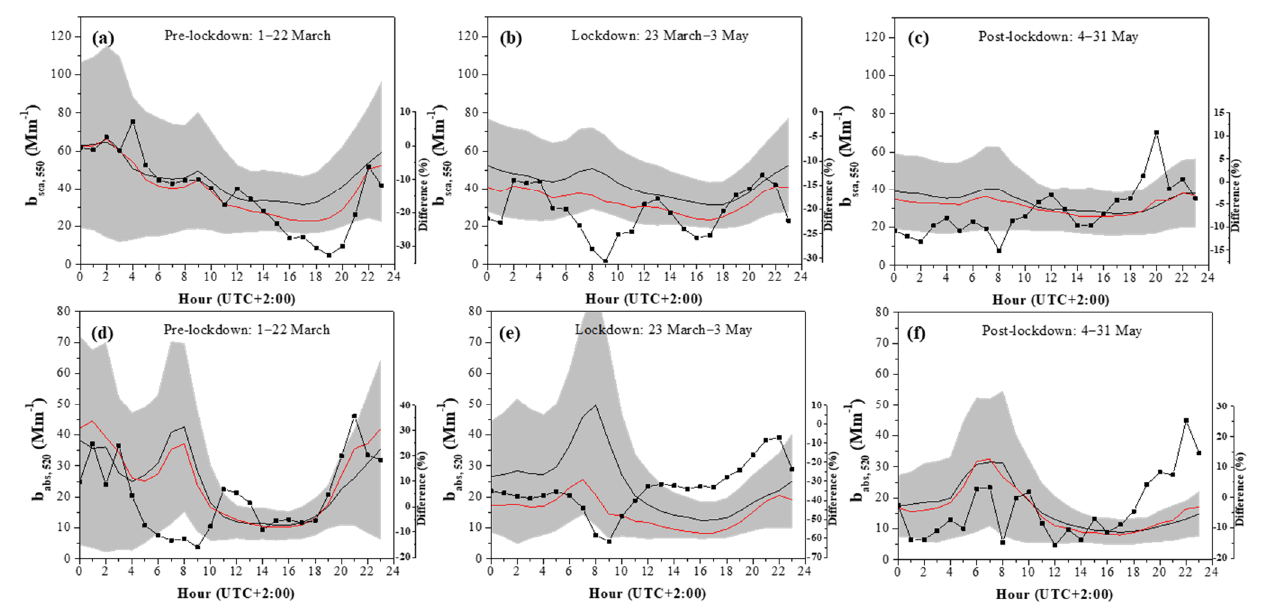
Figure 6. Mean diurnal variation of b sca,550 ( a – c ) and b abs,520 ( d – f ) for periods pre-, post- and during the lockdown. Red line corresponds to 2020, while the black line represents the mean for the years 2017–2019 for scattering and 2016–2019 for absorption. The shaded area corresponds to one standard deviation from the hourly mean during 2016–2019 and/or 2017–2019. The percentage (%) differences in b sca,550 and b abs,520 between the examined periods in 2020 and the mean of previous years are also shown.